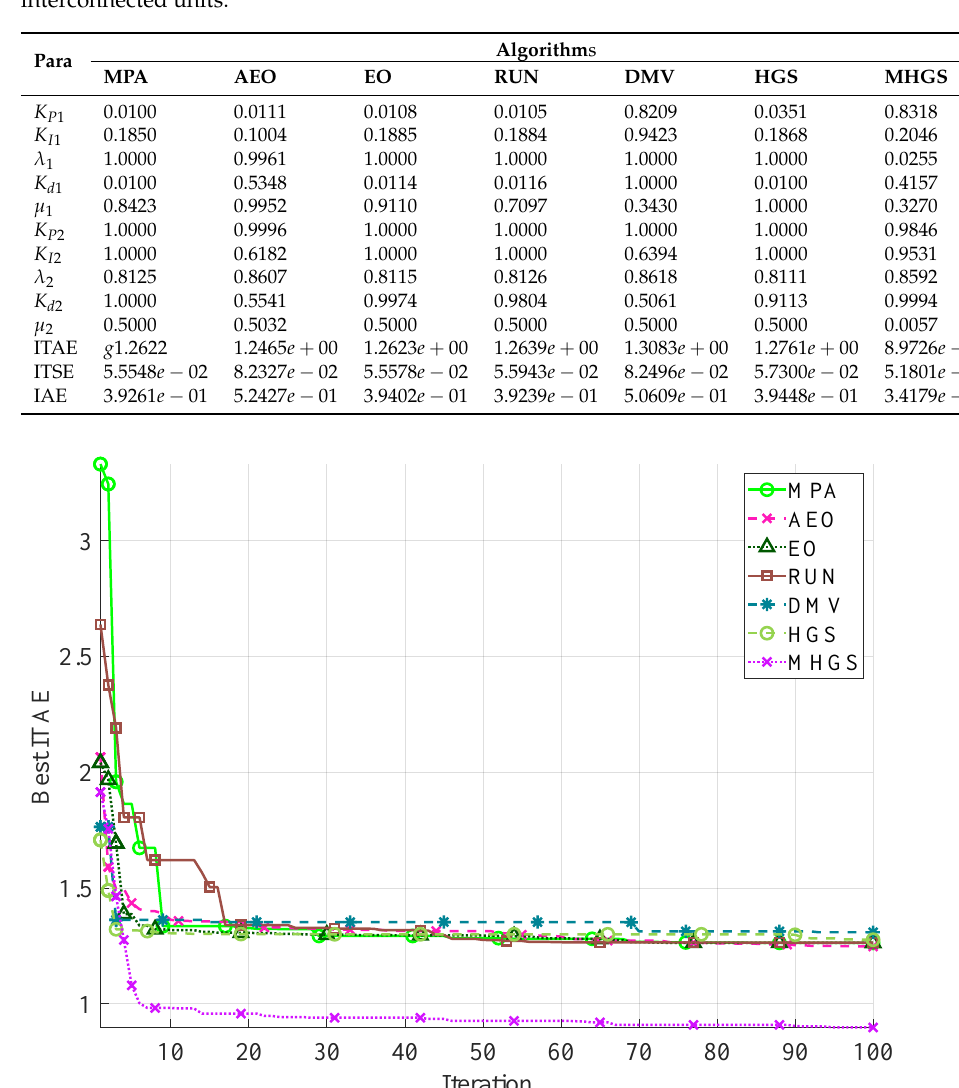
Table 1. The FOPID controller’s identified parameters by the tested techniques in the case of two interconnected units.